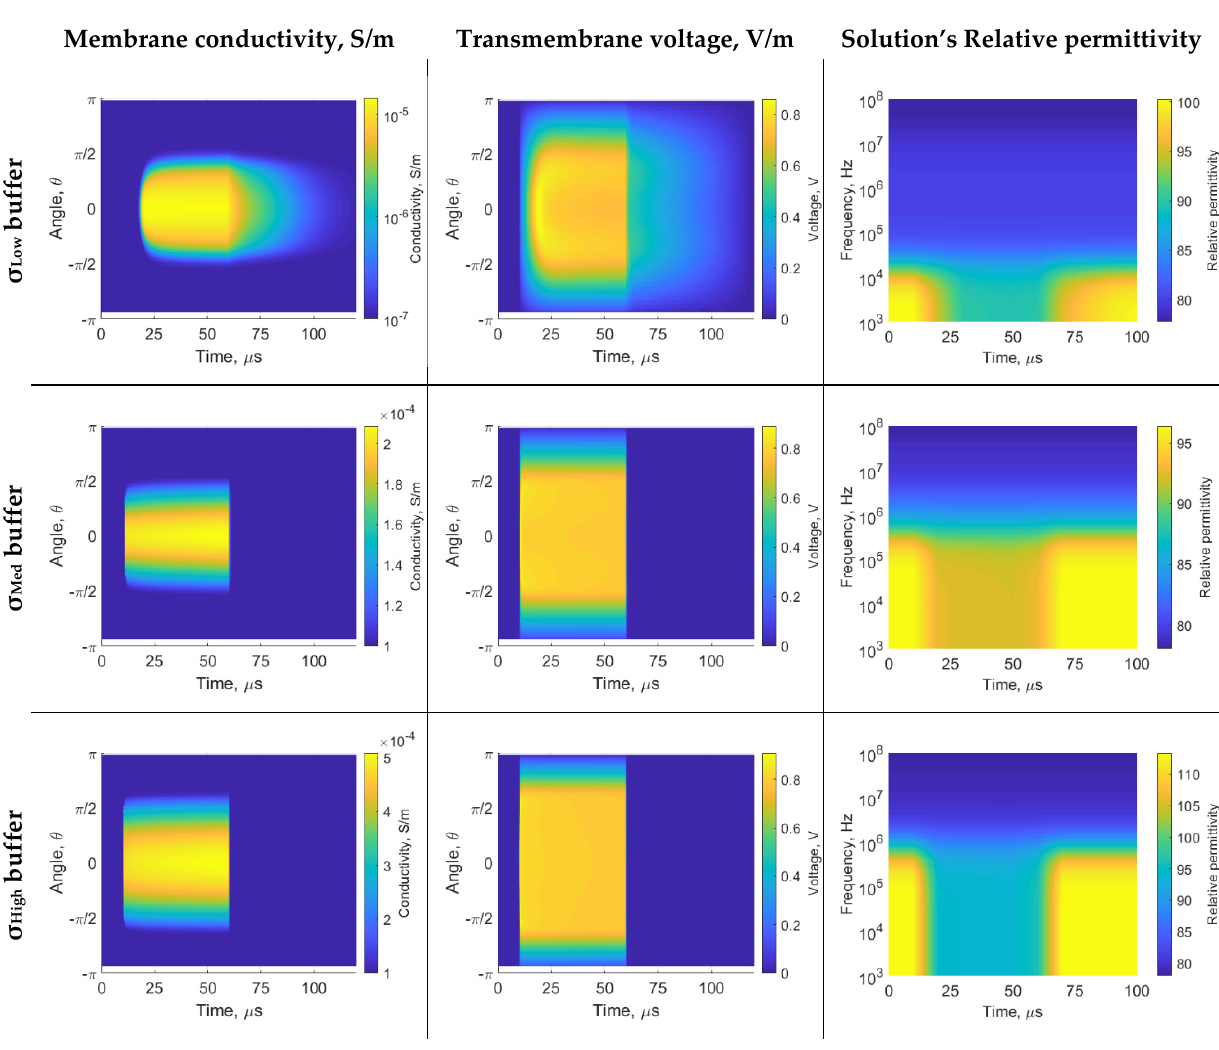
Figure 2. Results of 50 µs PEF: Membrane conductivity, transmembrane voltage and solution equivalent relative permittivity. The horizontal axis is the time in µs. The PEF starts at 10 µs and ends at 60 µs. The vertical axis of the membrane conductivity and transmembrane voltage figures represent the angle location in the membrane. The vertical axis of the solution relative permittivity figures is the sensing frequency (1 kHz to 100 MHz range).